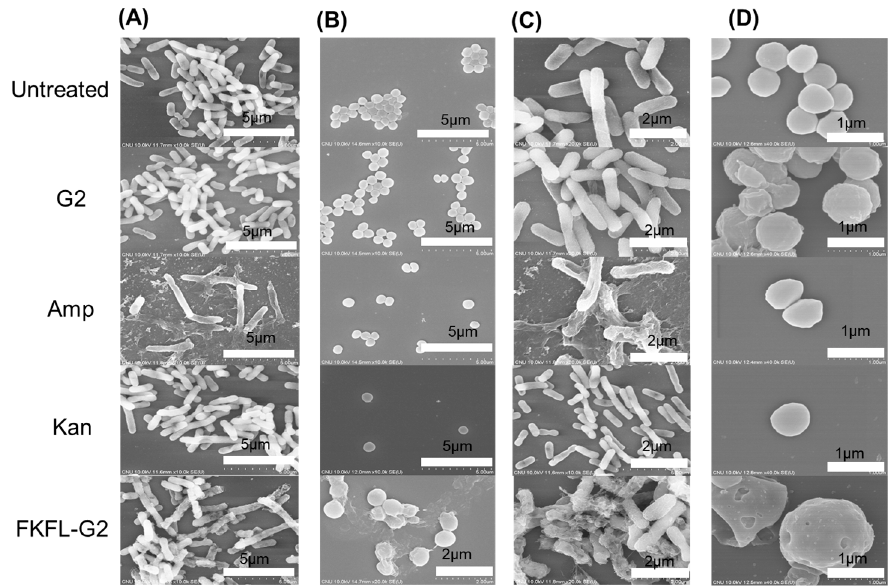
Figure 7. Bacterial morphology images of the untreated, G2-treated, Amp-treated, Kan-treated, and FKFL-G2-treated samples using field emission scanning electron microscopy at different magnifica- tions. ( A , C ) E. coli and ( B , D ) S. aureus bacteria strains.